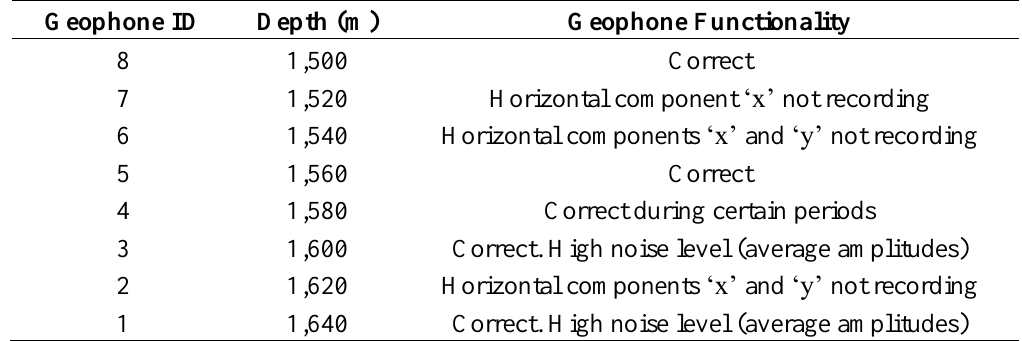
Table 1. Summary of geophone status obtained from spectrograms, noise level analysis and manual review of the data.